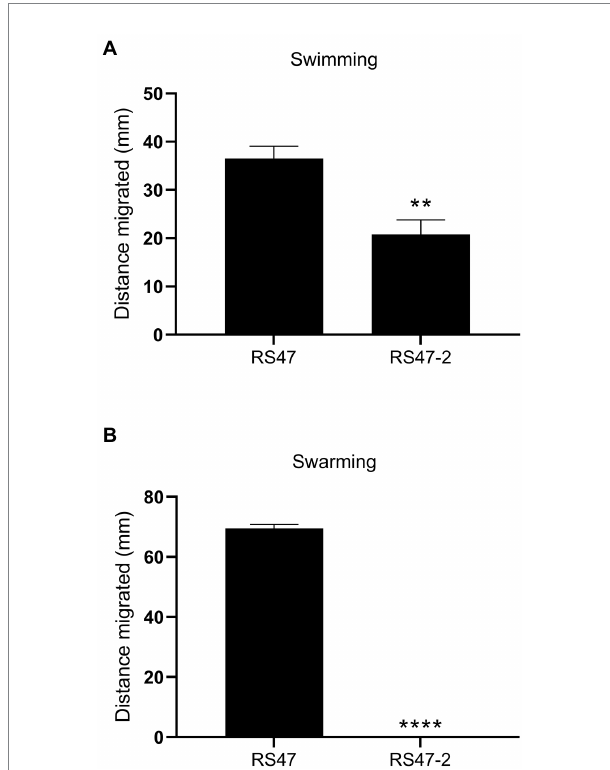
FIGURE 4 Impact of LPS alterations on motility. (A) Swimming ability of RS47 WT and RS47-2 in 0.3 % LB agar. Data shows distance migrated after 12 h incubation. (B) Swarming ability of RS47 WT and RS47-2. Data presented shows the diameter of swarm migration over 1.5 % LB agar from the central inoculum after 18 h incubation. A distance of zero mm indicates no expansion of the colony beyond the initial inoculum and no detectable swarming motility. All data represent the mean of five biological replicates and error bars show standard error of the mean (SEM). ** p ≤ 0.01; **** p ≤ 0.0001.